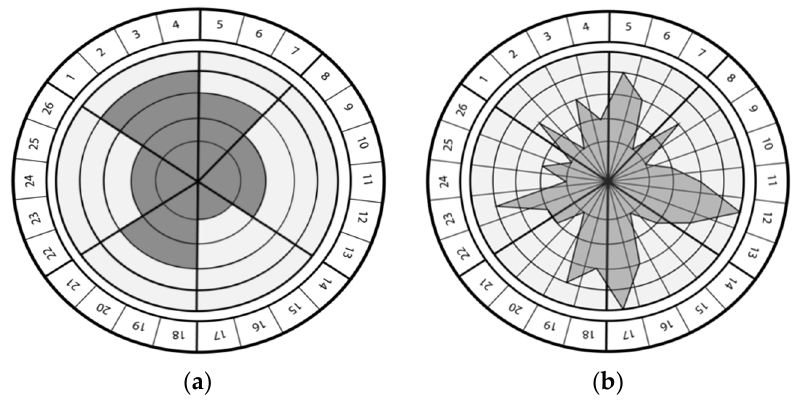
Figure 5. ( a ) Example of a company’s dimensions maturity level in I4. ( b ) Example of a company’s sub-dimensions maturity level in